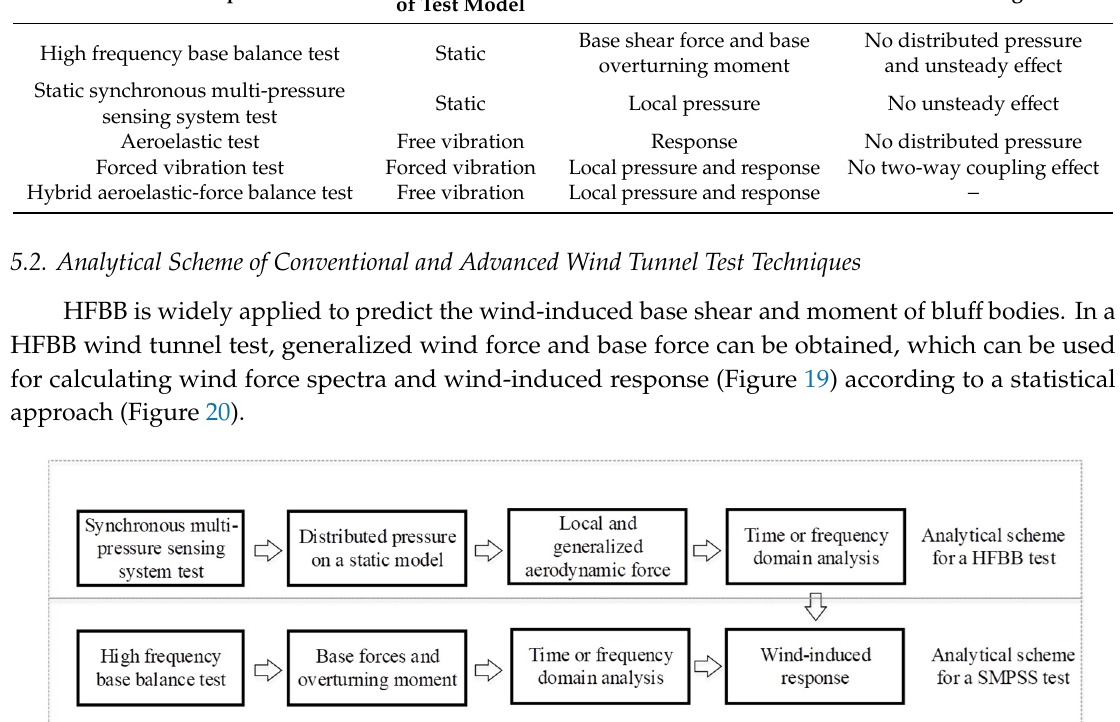
Figure 19. Analytical scheme for a high frequency base balance test or static synchronous multi-pressure sensing system test.